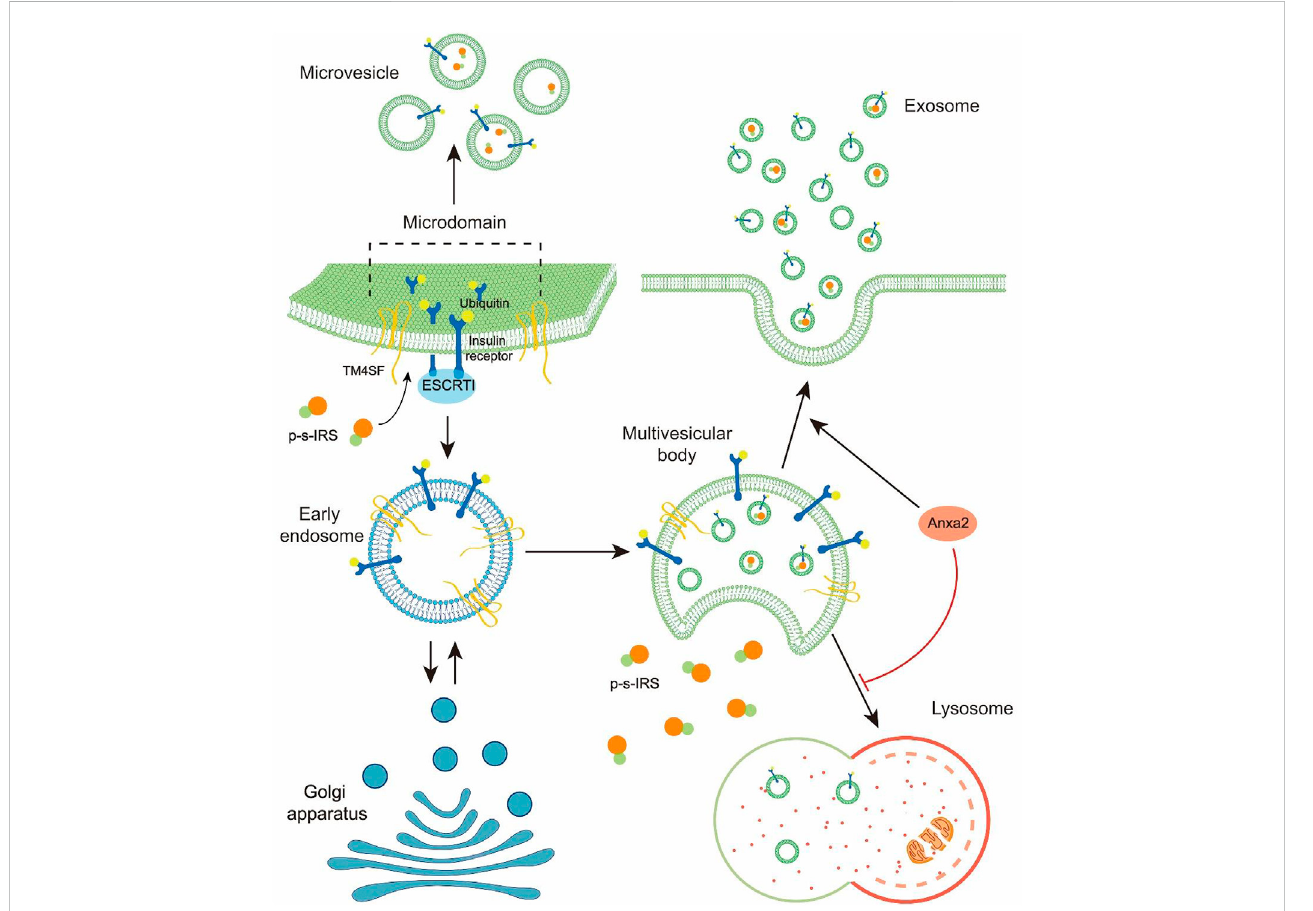
Diagram depicts that p-s-IRS is selectively loaded into EVs and released to the extracellular